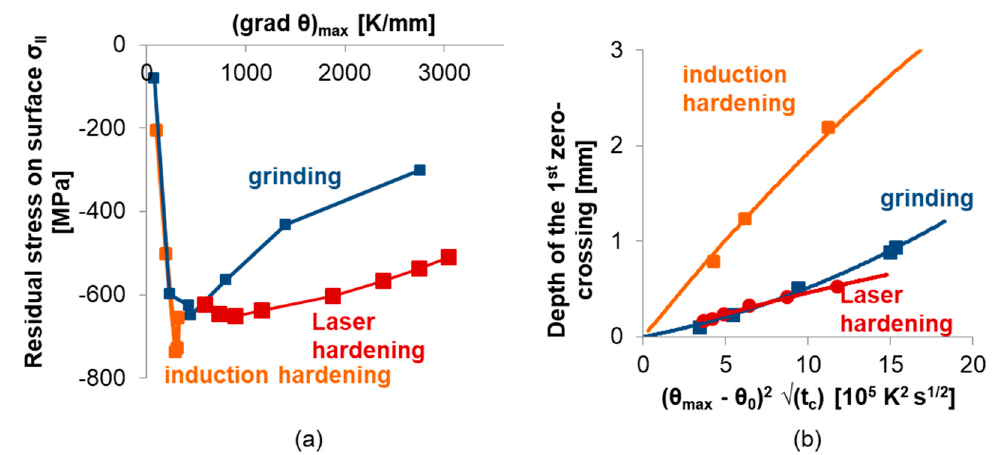
Figure 12. Comparison of calculated target quantities for induction, grind, and laser hardening plotted over ( a ) (grad θ ) max for the residual stresses at the surface and ( b ) over ∆𝜃 (cid:3040)(cid:3028)(cid:3051)(cid:2870) ∙ (cid:3493)𝑡 (cid:3030) for the 1st zero-crossing. The simulations are performed with the QT 30HRC variant as initial microstructure [7].